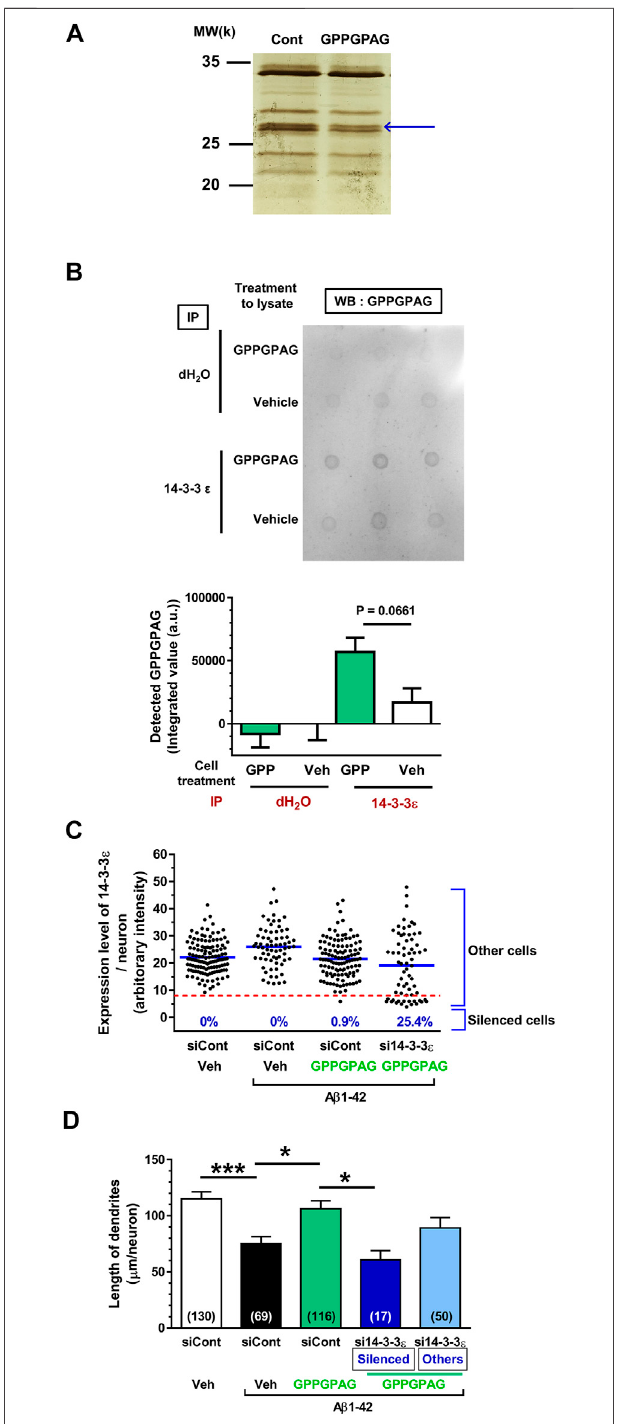
FIGURE 5 | Direct binding protein of GPPGPAG in the neurons is 14-3-3 ε . (A) Mouse cortical neuron primary cultures (ddY, E14) were treated by vehicle solutionorGPPGPAG(10 nM)for30 min.CelllysatewasusedinDARTSreaction andtheseparatedproteinsweresilverstained. (A) AbandintheGPPGPAG- treatedneuronthatwasthinnerthaninthevehiclesolution-treatedneurons(Cont), wascutoutandanalyzedbynanoLC-MS/MS(bluearrow).Fullgelimageisshown